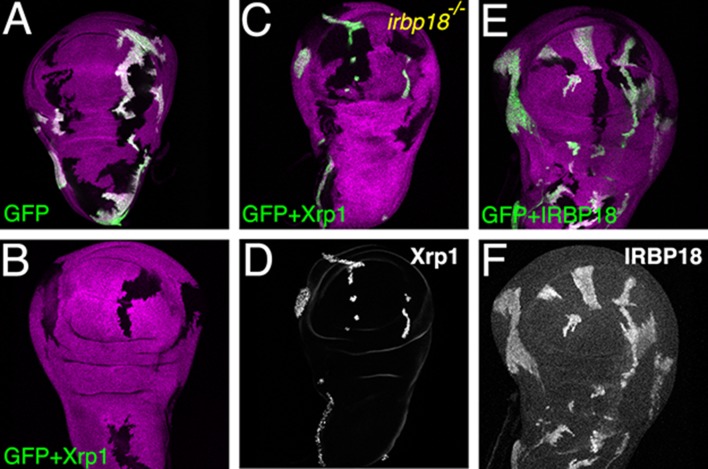
Ectopic Xrp1 requires IRBP18 to affect clone survival.(A) Wing imaginal discs containing clones of control cells lacking b-galactosidase (magenta) and reciprocal clones expressing GFP (green). In panels B-D) Xrp1 is co-expressed with GFP. Xrp1 led to complete elimination of GFP-positive lineages in the irbp18+/+ background (B), but not when irbp18 was mutated (C). Panel D shows that the GFP-marked clones nevertheless highly over-expressed Xrp1 protein in the irbp18-/- background. (E,F) co-expression of Irbp18 with GFP had no effect on clone survival, even though Irbp18 protein was highly over-expressed (F). Genotypes A) y w hs-FLP; tubP-GAL4 UAS-mCD8::GFP/+; FRT82B arm-LacZ/FRT82B tubP-GAL80. B) y w hs-FLP; tubP-GAL4 UAS-mCD8::GFP/UAS-Xrp1; FRT82B arm-LacZ/FRT82B tubP-GAL80. C–D). y w hs-FLP; tubP-GAL4 UAS-mCD8::GFP/UAS-Xrp1; irbp18f05006 arm-LacZ FRT80/tubP-GAL80 FRT80. E,F). y w hs-FLP; tubP-GAL4 UAS-mCD8::GFP/UAS-irbp18; arm-LacZ FRT80/tubP-GAL80 FRT80.